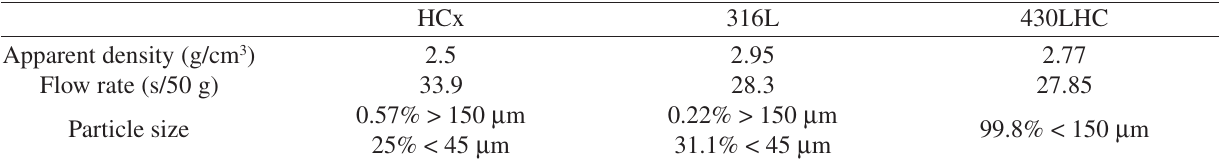
Table 2. Characteristics of initial materials.